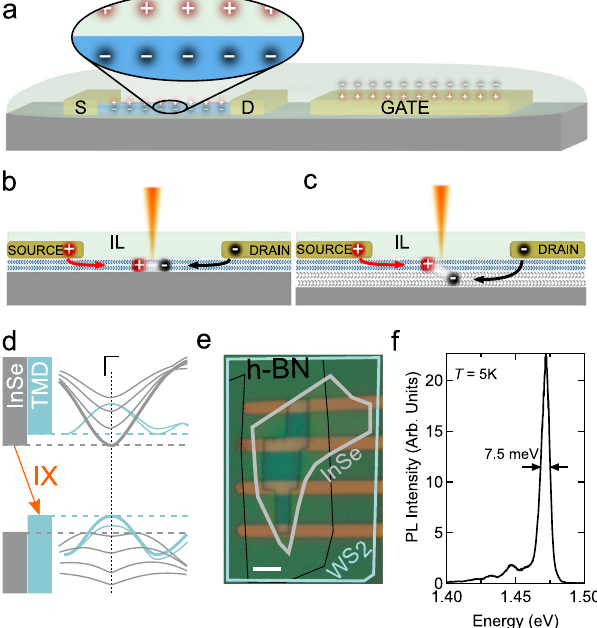
Fig. 1 LEFETs based on van der Waals interfaces. a Schematics of an ionic- gated fi eld-effect transistor, with the source-drain (S-D) contacts connected to a semiconducting layer and the gate electrode, all in contact with an ionic liquid. The zoom in on the channel regions shows that upon the application of a gate voltage charge is accumulated on the semiconductor (see Supplementary Section 1 for details). b , c Electron-hole recombination in the channel of an ionic liquid (IL)-based LEFET operated in the ambipolar injection regime (with electrons and holes injected at opposite contacts) for a device based on an individual 2D material ( b ) and on a vdW interface ( c ). In the latter case, light is emitted by the recombination of electrons and holes hosted in different layers, which offers new opportunity to control its spectrum (see main text; here we use interfaces of bilayer TMDs, hosting holes, and InSe multilayers, hosting electrons). d The type-II band alignment between InSe and TMDs around the Γ -point enables k -direct interlayer radiative transitions between the two band edges (as indicated by the orange arrow and labeled IX). Higher energy bands originating from the quantum con fi nement of charge carriers in the two layers (as indicated by the thin lines) can lead to radiative transitions with different energy. e Optical micrograph of a device used in this work, based on 2L-WS 2 and 4L InSe (the contours of the layers are marked by the blue and white lines; the stacking sequence is indicated on top). The vdW interface is in contact with the liquid through an opening in the PMMA layer covering the entire sample. The scale bar is 2 μ m. f Peak in the PL spectrum of a 5L InSe crystal encapsulated between two thicker hBN layers: the narrow width indicates the high quality of the material.